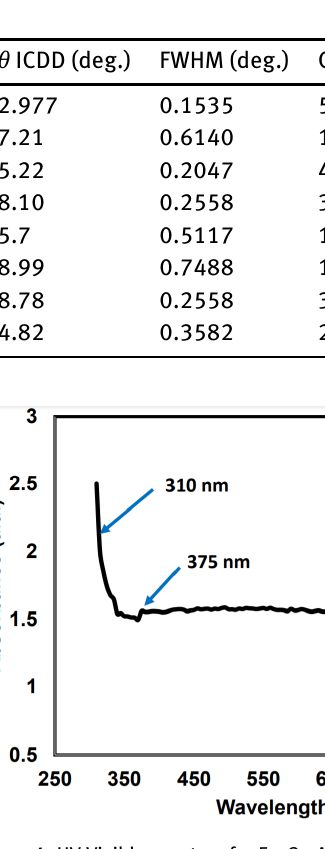
Figure 4: UV-Visible spectra of 𝛾 -Fe 2 O 3 -Ag 2 O